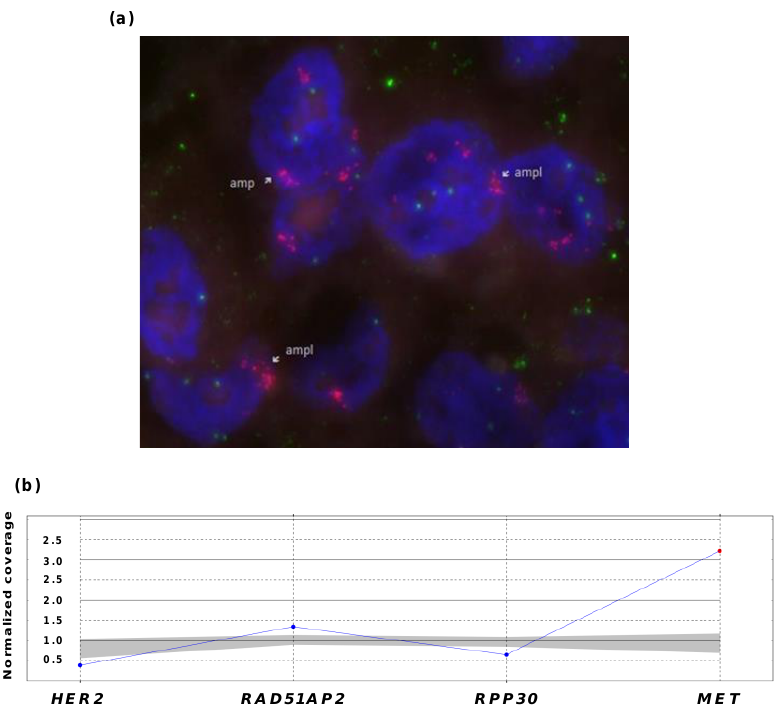
Figure 8. Results of MET -positive NSCLC sample analysis using FISH and ddPCR. ( a ) FISH assay. Green dots correspond to D7Z1 probes marking the chromosome 7 centromere, red dots correspond to probes marking the MET gene region at 7q31. ( b ) Multiplex ddPCR assay. X-axis shows genes, and Y-axis represents the ratio of gene concentration to normalized concentration of both reference genes.